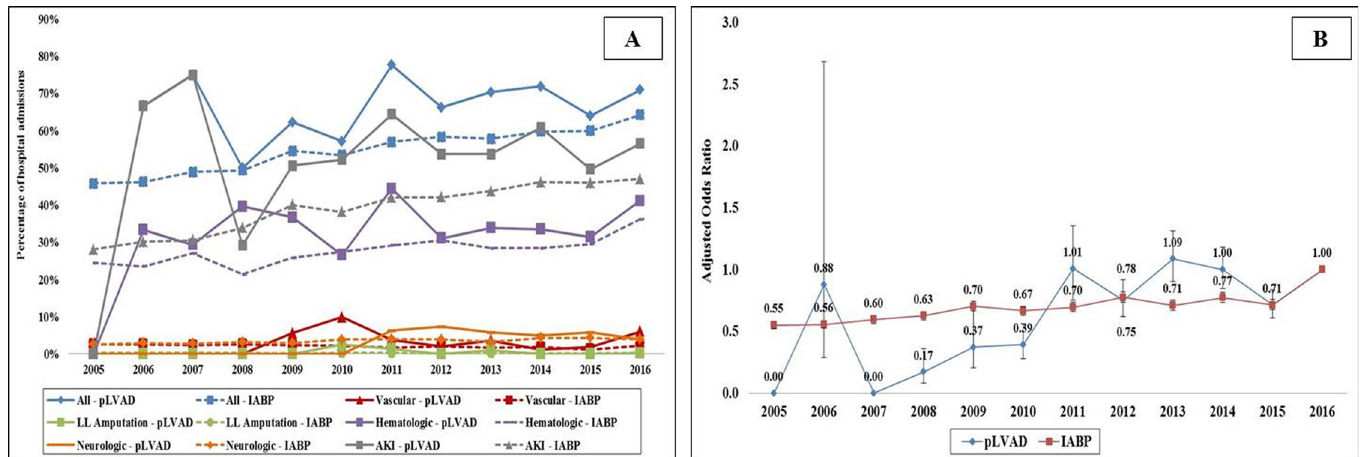
Fig 3. Trends of complications in AMI-CS supported with pLVAD and IABP. Legend: A: Unadjusted temporal trends in AMI-CS by pLVAD and IABP use ( p < 0.001 for trend over time); D: Adjusted multivariate logistic regression temporal trends of complications stratified by pLVAD and IABP use with 2016 as referent year; adjusted for age, sex, race, comorbidity, primary payer, socio-economic stratum, hospital characteristics, AMI type, acute organ failure, cardiac arrest, coronary angiography, percutaneous coronary intervention, invasive hemodynamic monitoring; extracorporeal membrane oxygenation use, invasive mechanical ventilation, hemodialysis and receipt of cardiac surgery ( p < 0.001 for trend over time). Abbreviations: AKI: acute kidney injury; IABP: intra-aortic balloon pump; LL: lower limb; pLVAD: percutaneous left ventricular assist device.